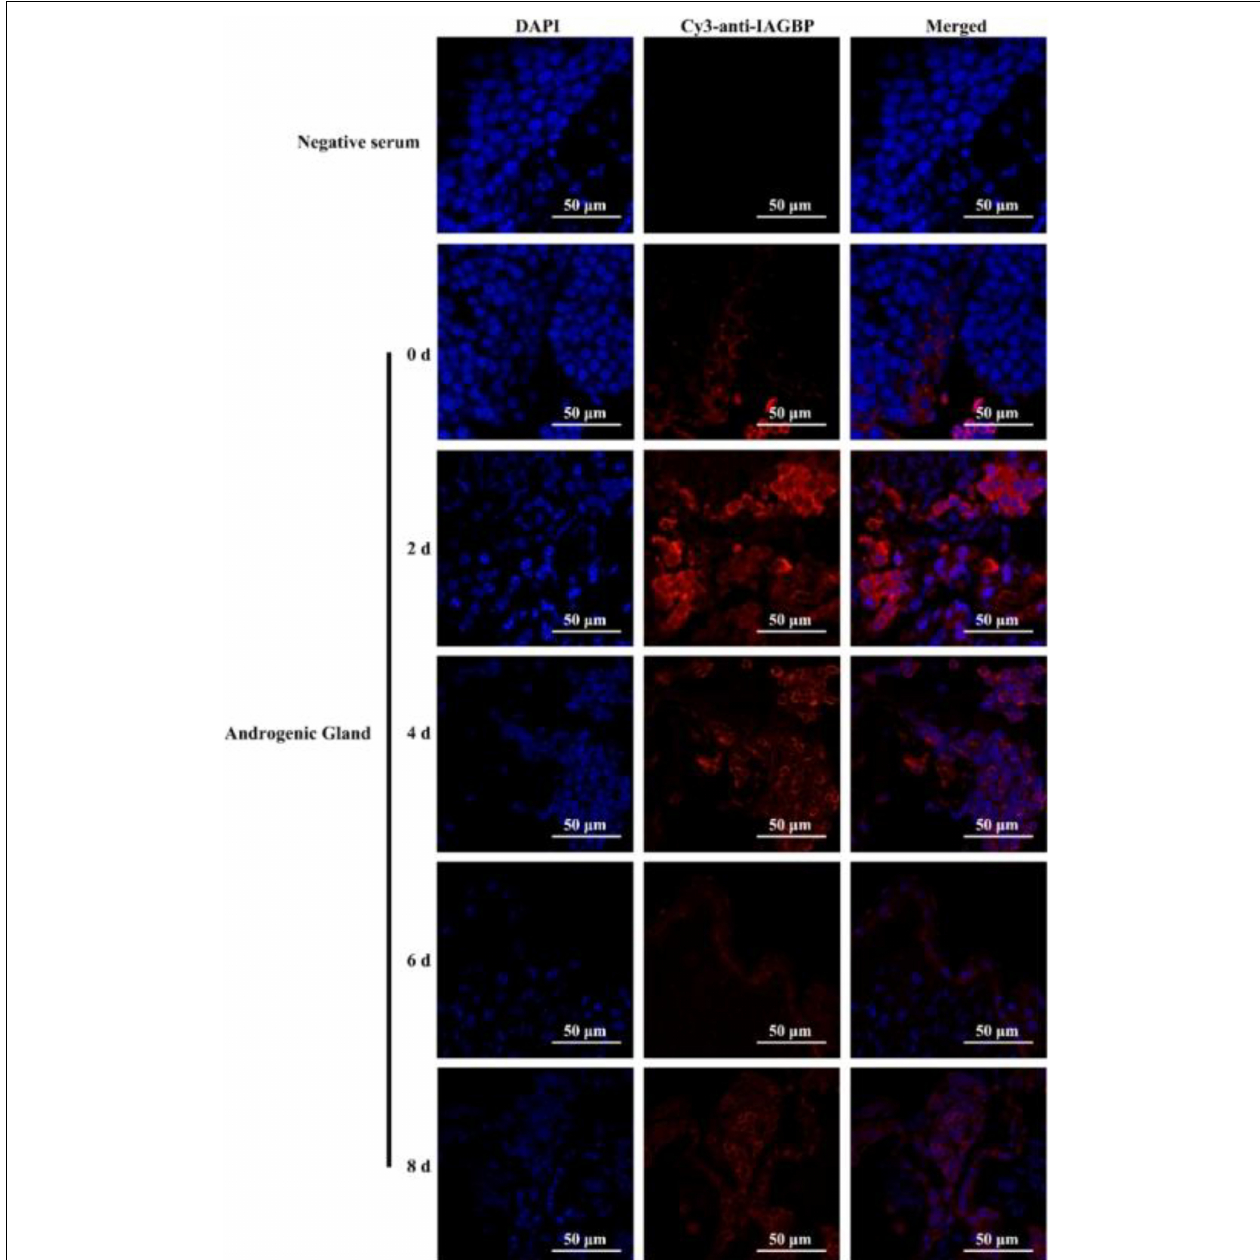
FIGURE 10 | The protein expression levels of Mr IAGBP on different days in androgenic gland after bilateral eyestalk ablation. Mr IAGBP was in red fluorescence signals. Negative serum served was as the control. Scale bar was indicated 50 µ